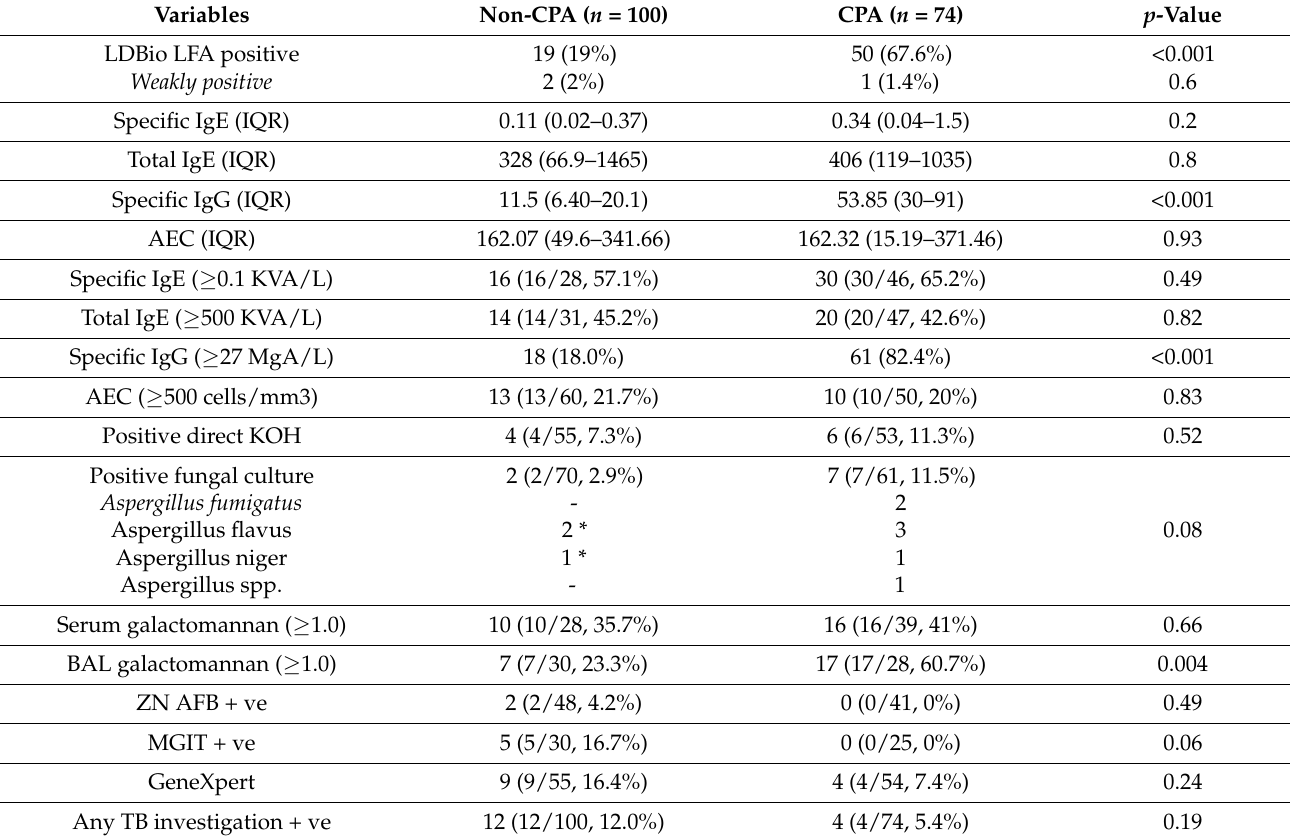
Table 3. Comparison of laboratory parameters.